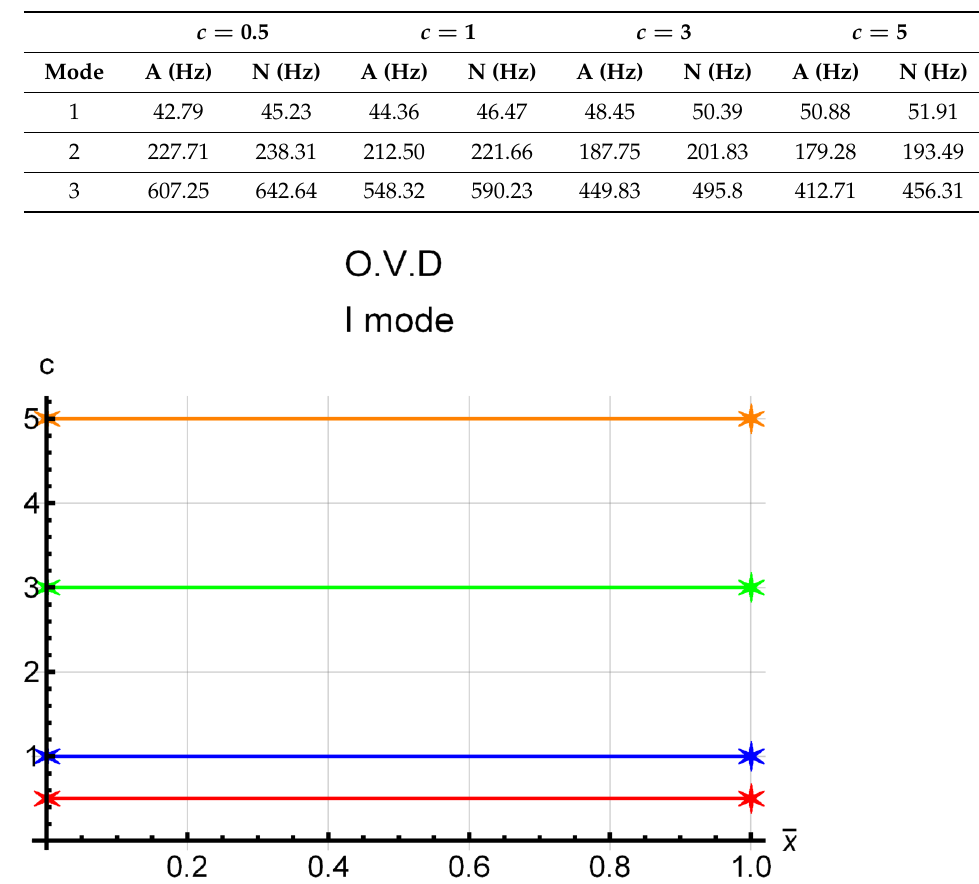
Table 4. Comparison between analytical and numerical eigenfrequencies for the first three modes and several tapering ratios. A = analytical result, N = FEM result.